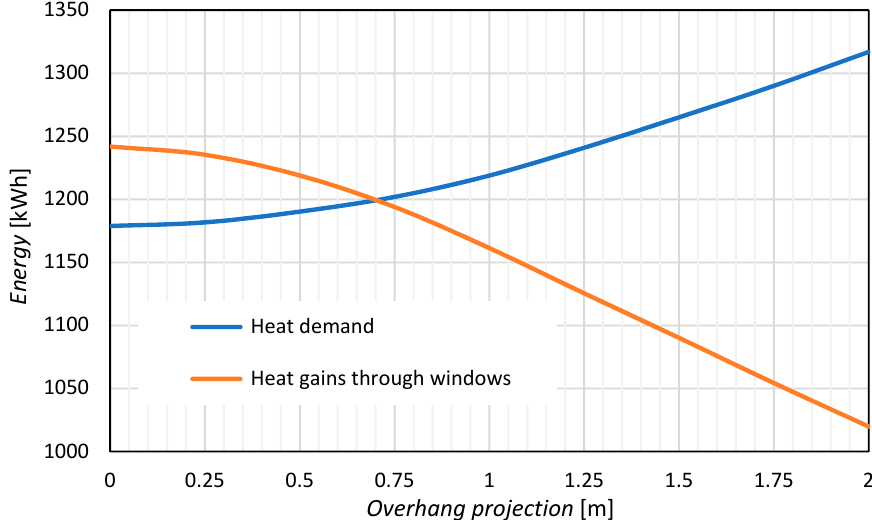
Figure 8. The dependence of heat gains and losses on the overhang length during the heating season in the analyzed modular house.